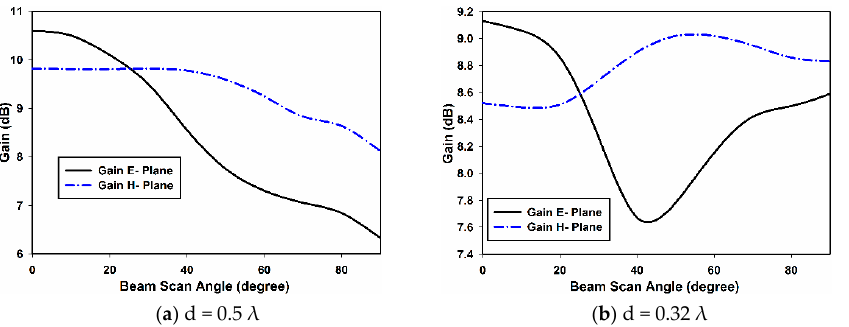
Figure 12. Measured gain of the E- and H-plane arrays.